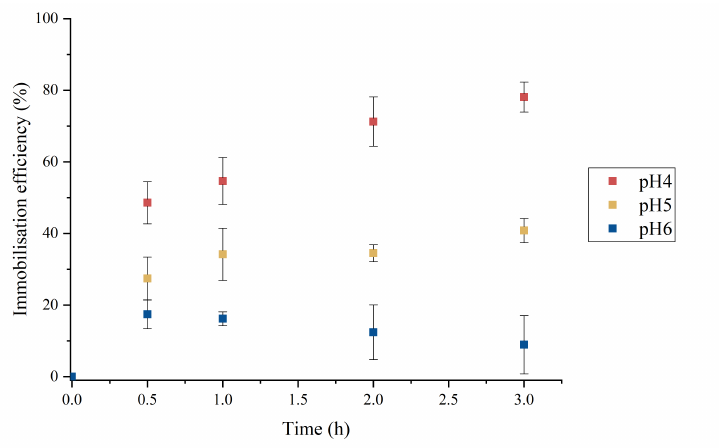
Figure 1. Effect of pH on the adsorption process. (Conditions used for the experiments are: laccase concentration: 1 mg·mL − 1 , temperature: 20 ◦ C, adsorption time: 3 h. pH = 4, 5,